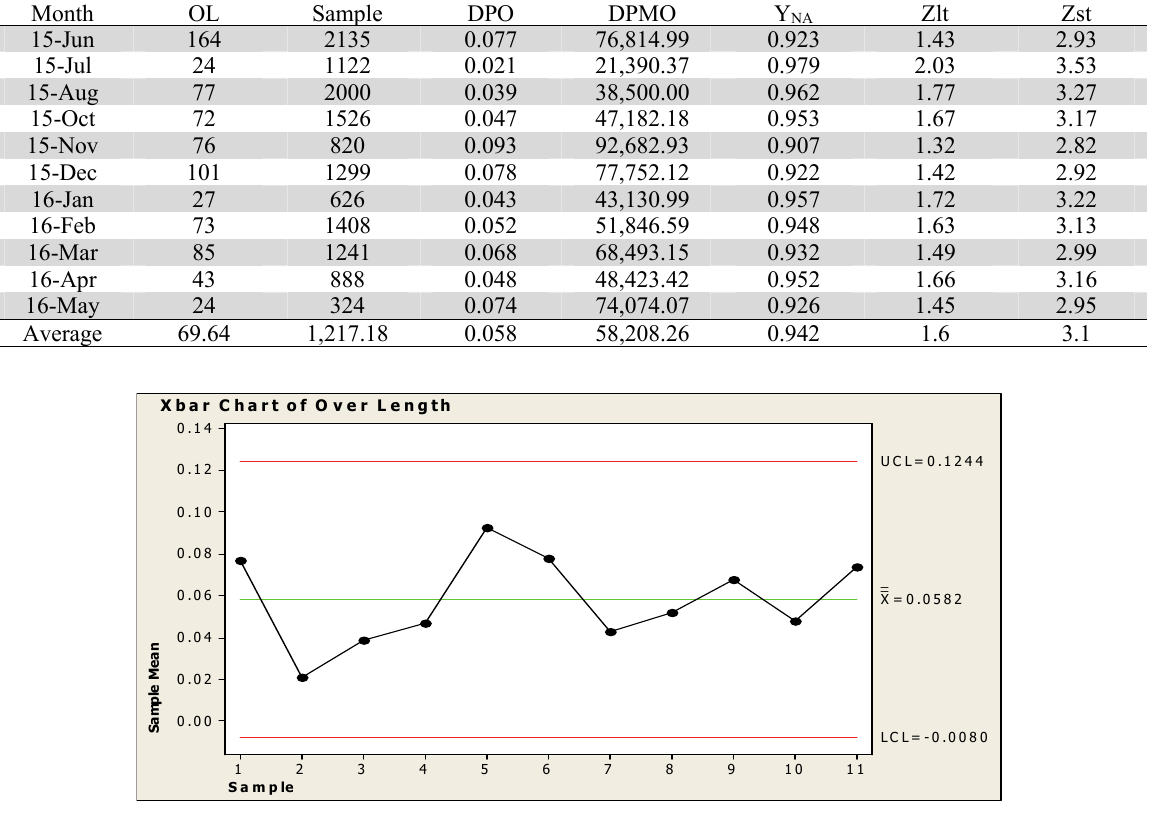
Fig. 5. Process Capability Control Diagram